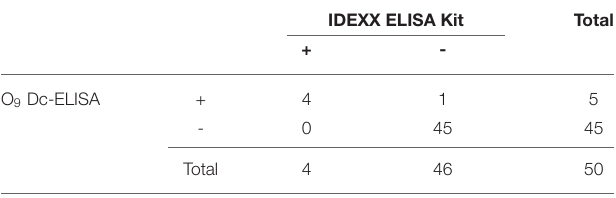
TABLE 2 | Comparison of the results between O 9 Dc-ELISA and IDEXX ELISA kit.